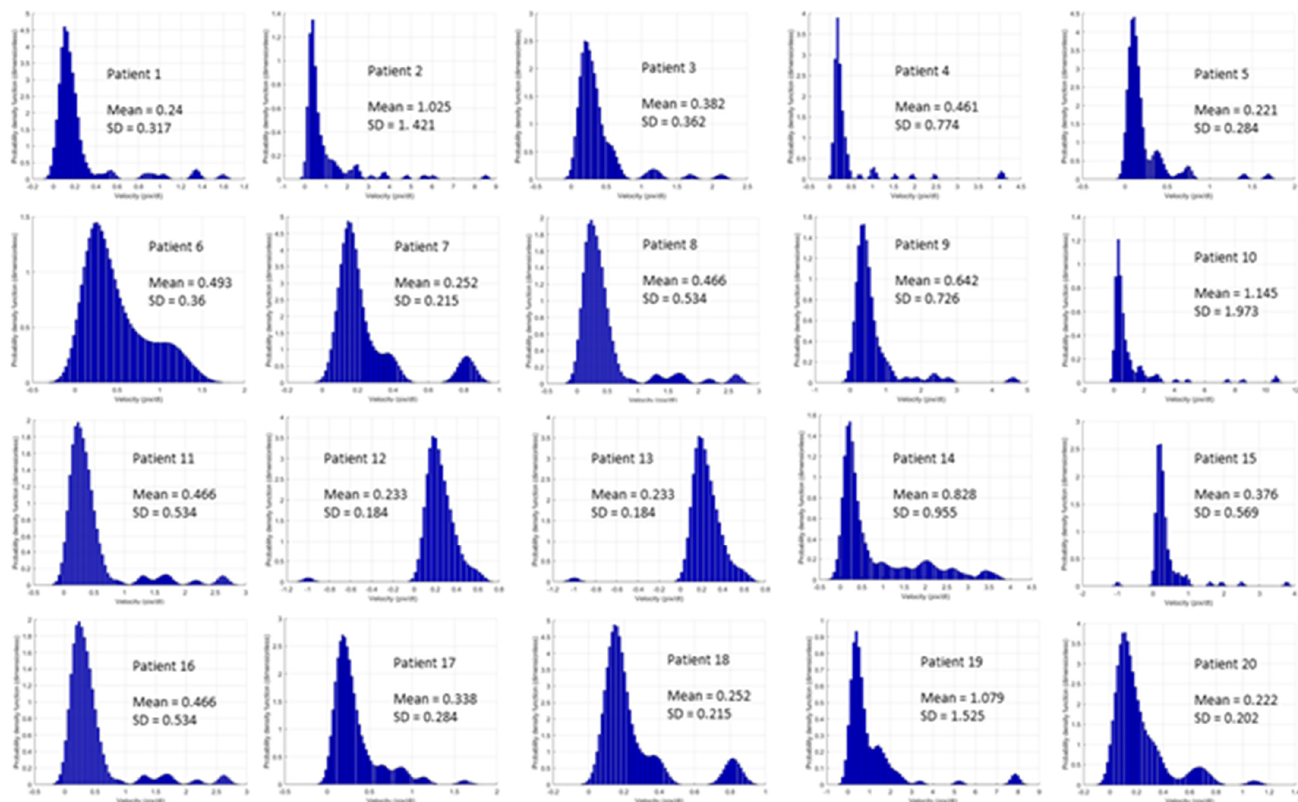
Figure 2. Probability density functions of velocity distributions. Note the velocity values (mean) and the standard deviation (SD). Transverse axis: RBC velocity (pix dt -1 ); Vertical axis: Probability density function (dimensionless).